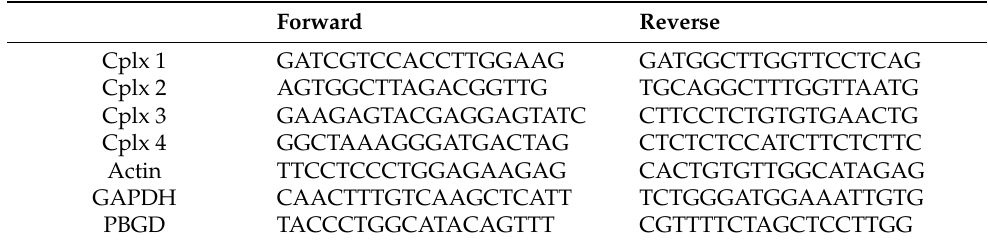
Table 1. Specific primer pairs for RT-qPCR (5 (cid:48) –3 (cid:48)